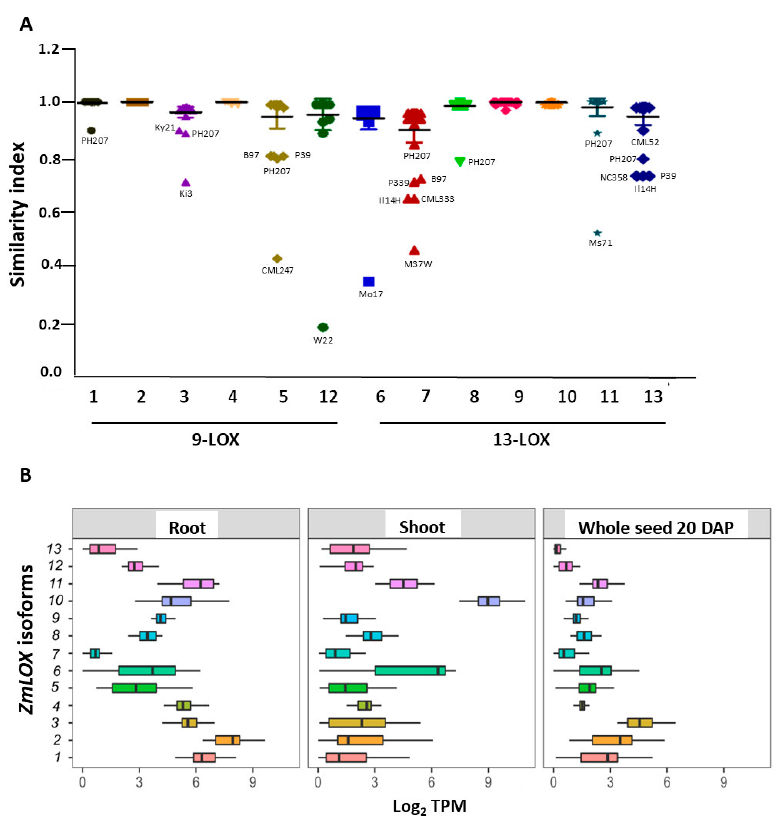
Figure 1. In silico analysis of maize intraspecific ZmLOX protein sequence diversity and tissue- specific gene expression. ( A ) Global Blosum62 similarity index of ZmLOX protein sequences derived from B73_v5, the 25 NAM founders and Mo17, W22, PH207, EP1, and F7 inbred line genomes available at maizeGDB. The horizontal bar indicates the mean value of the similarity index for each ZmLOX. ( B ) Basal ZmLOX transcript abundance in the root, shoot, and whole seed at 20 days after pollination (DAP). Data were extracted from transcriptomic datasets of B73_v5 and 25 NAM lines available at maizeGDB and expressed as log 2 transcripts per million (TPM). In the graphs, vertical lines within boxes indicate the median, and boxes indicate the upper (75%) and lower (25%) quartiles. Whiskers indicate the range of the minimum and maximum values.